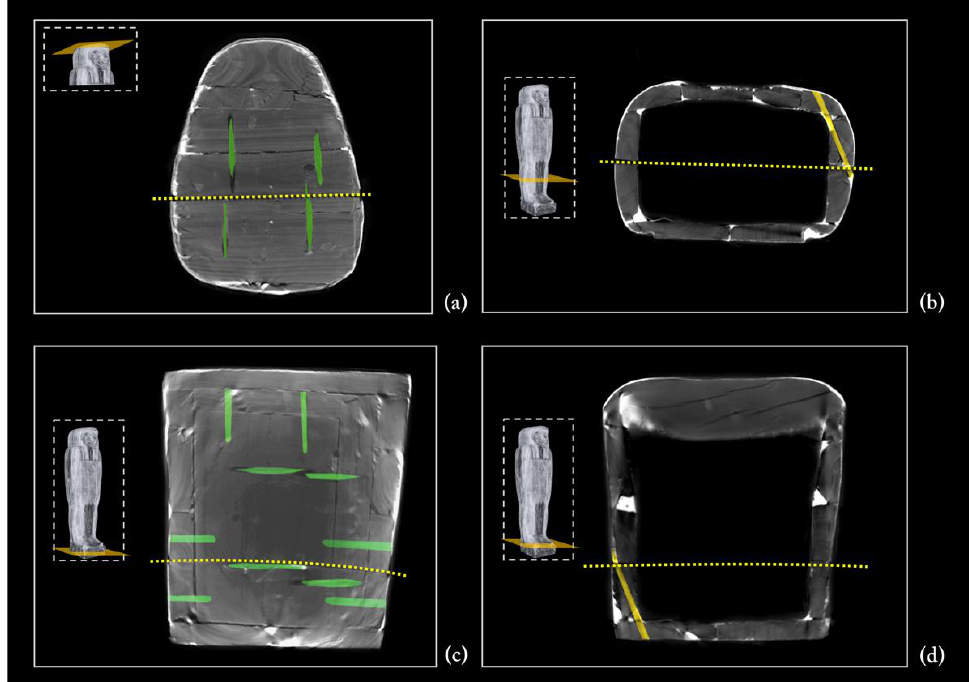
Figure 22. The dowels cut at the division of the coffin in the head wall ( a ), legs ( b ), foot board ( c ), and feet ( d